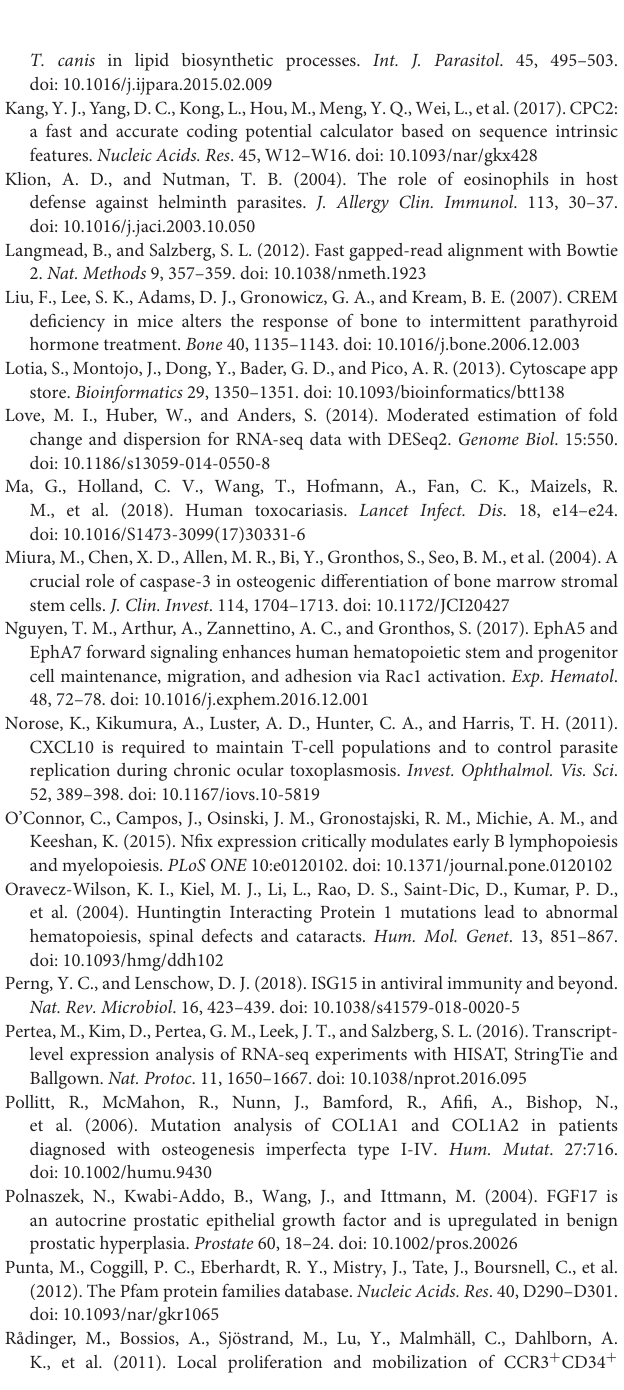
Supplementary Table 4 | Gene Ontology (GO) terms of cis target genes of the differentially expressed lncRNAs. Supplementary Table 5 | Gene Ontology (GO) terms of the differentially expressed mRNAs. Supplementary Table 6 | Signaling pathways of the differentially expressed